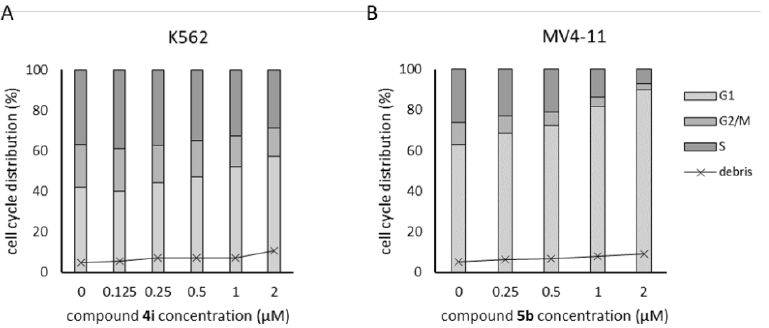
Figure 13. Cell cycle distribution in K562 ( A ) and MV4-11 ( B ) cells treated with 4i and 5b , respectively, for 24 h.